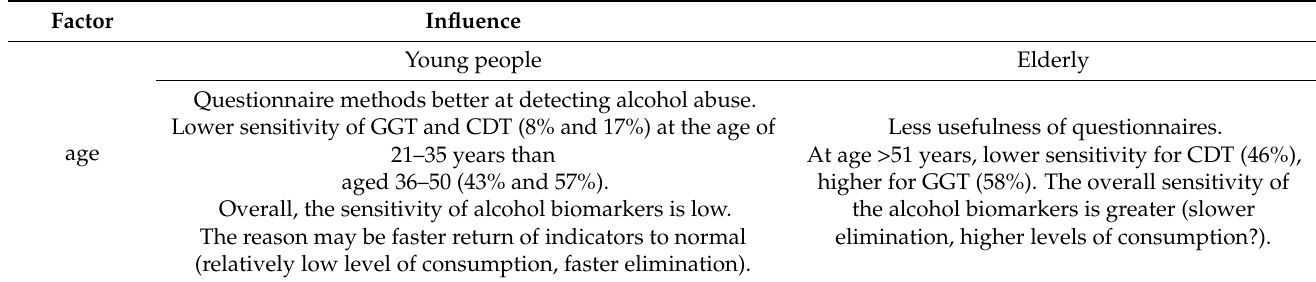
Table 2. Factors that influence sensitivity and specificity of traditional